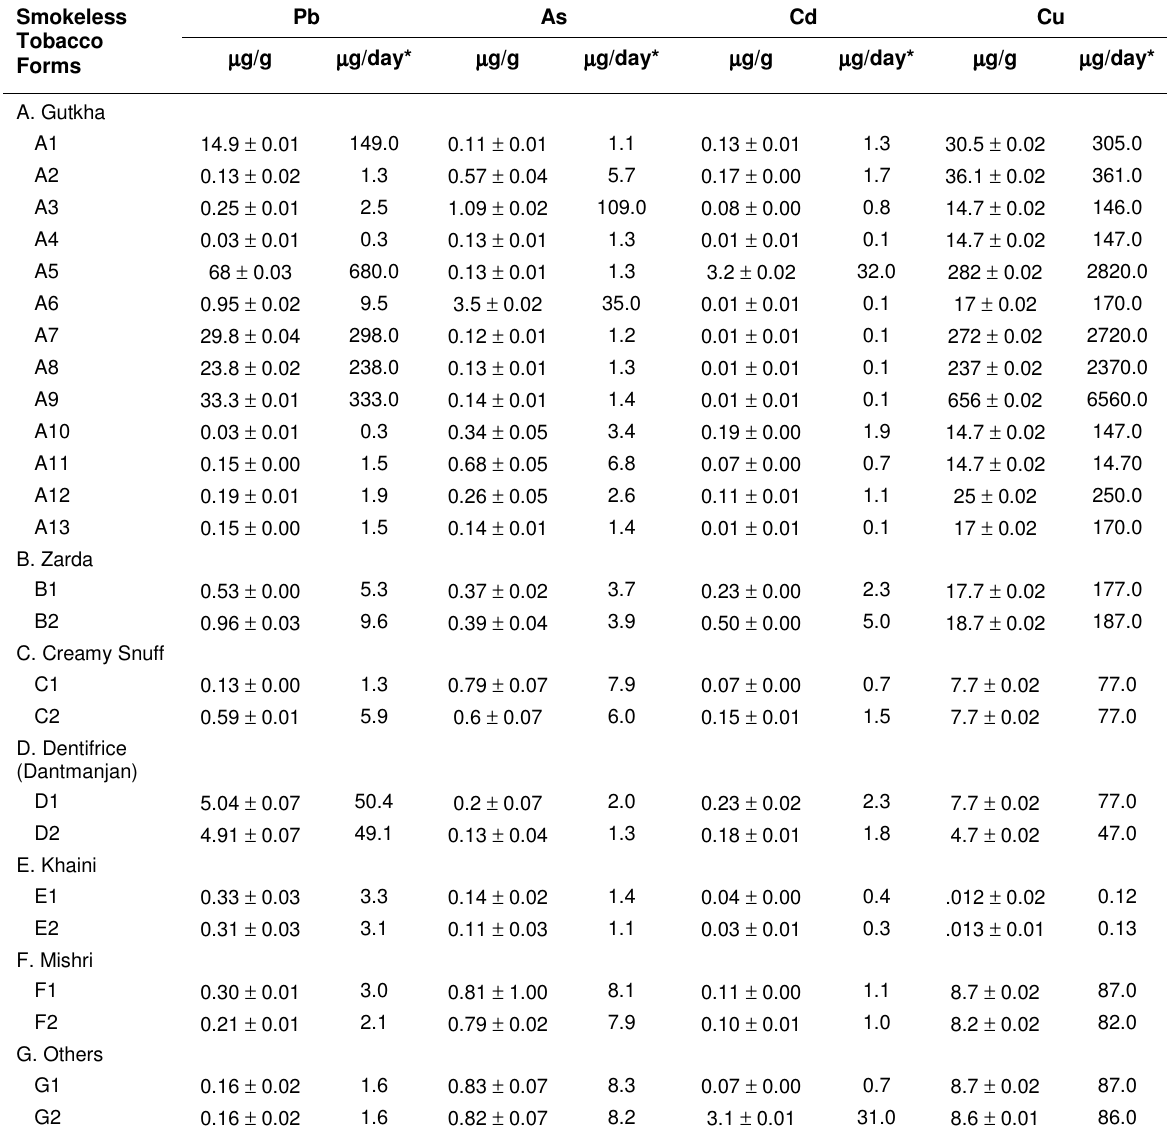
Observed Levels of Heavy Metals in STPs with ( ±±±± ) Standard